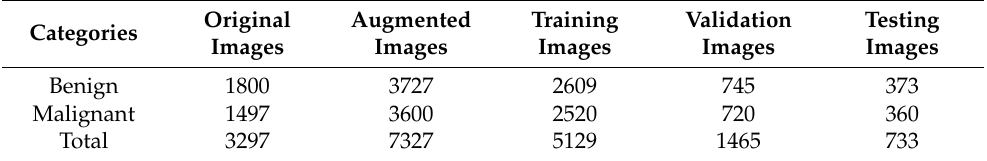
Table 1. A detailed description of the